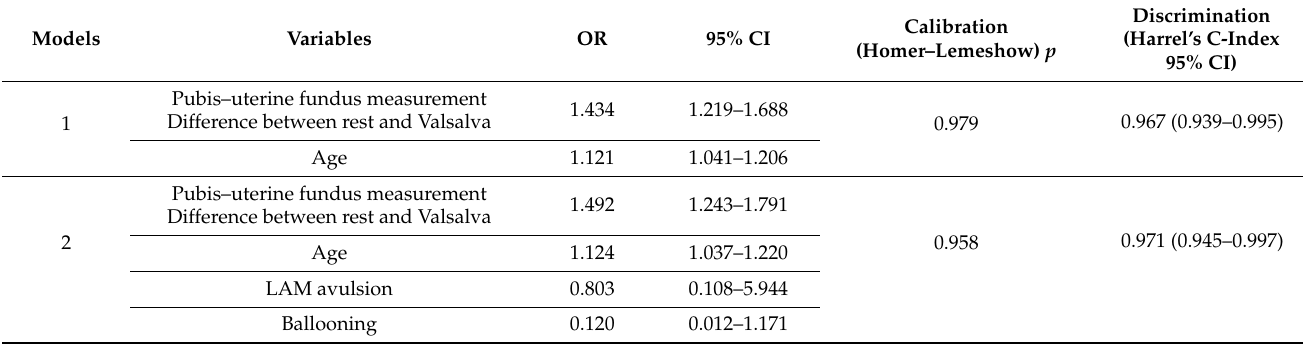
Table 3. Evaluation of the